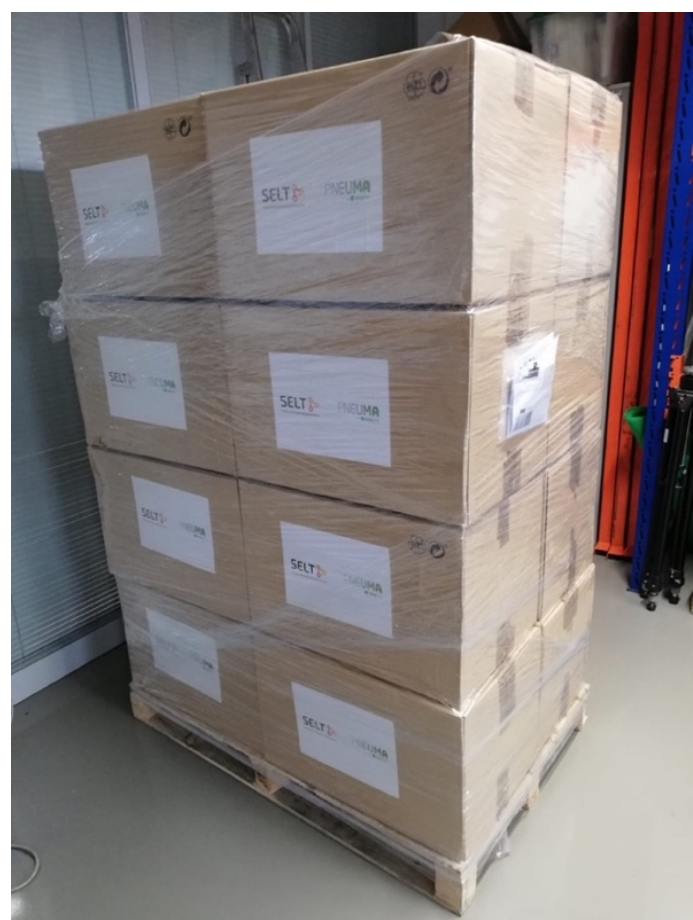
Fig. 6. The first 16 Pneuma unit’s pallet delivered to ARS-Norte in June